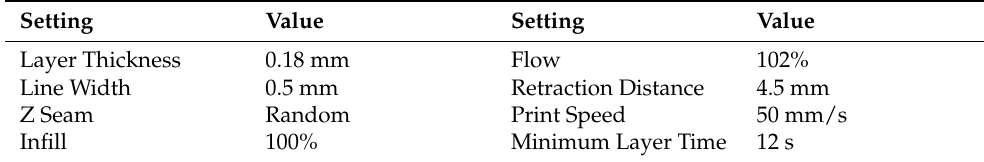
Table 1. 3D printing process parameters.